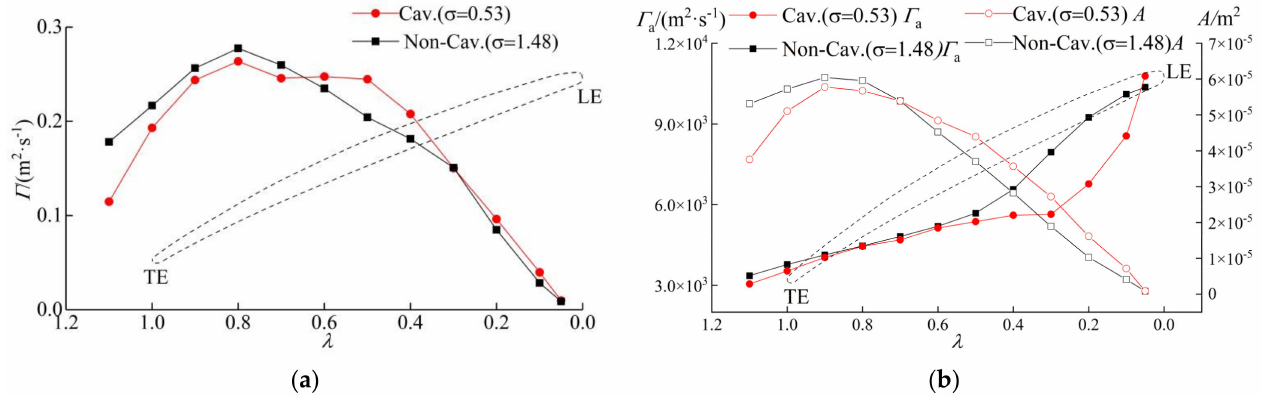
Figure 12. Comparison of the vortex strength and vortex area distribution for the cavitating case ( σ = 0.53) and non- cavitating case ( σ = 1.48). ( a ) Vortex strength Γ distribution curve; ( b ) Distribution curves of average vortex strength Γ a and vortex area